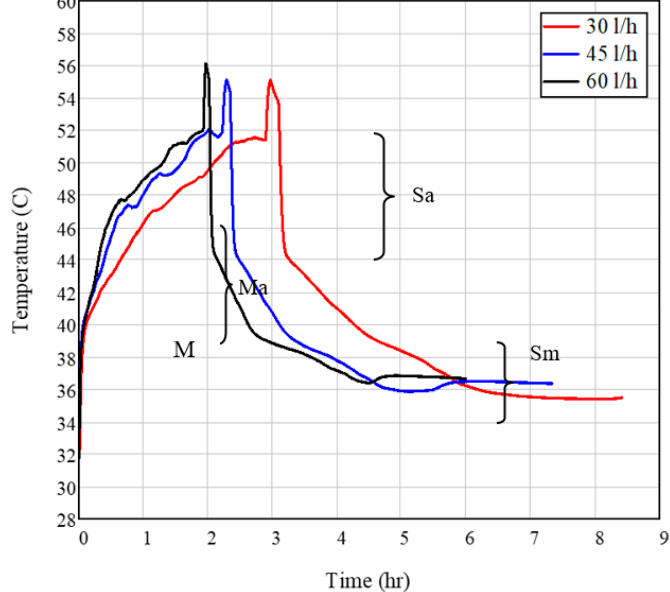
Figure 8. Mean temperature profiles of A44 for charging and discharging and three HTF flow rates.